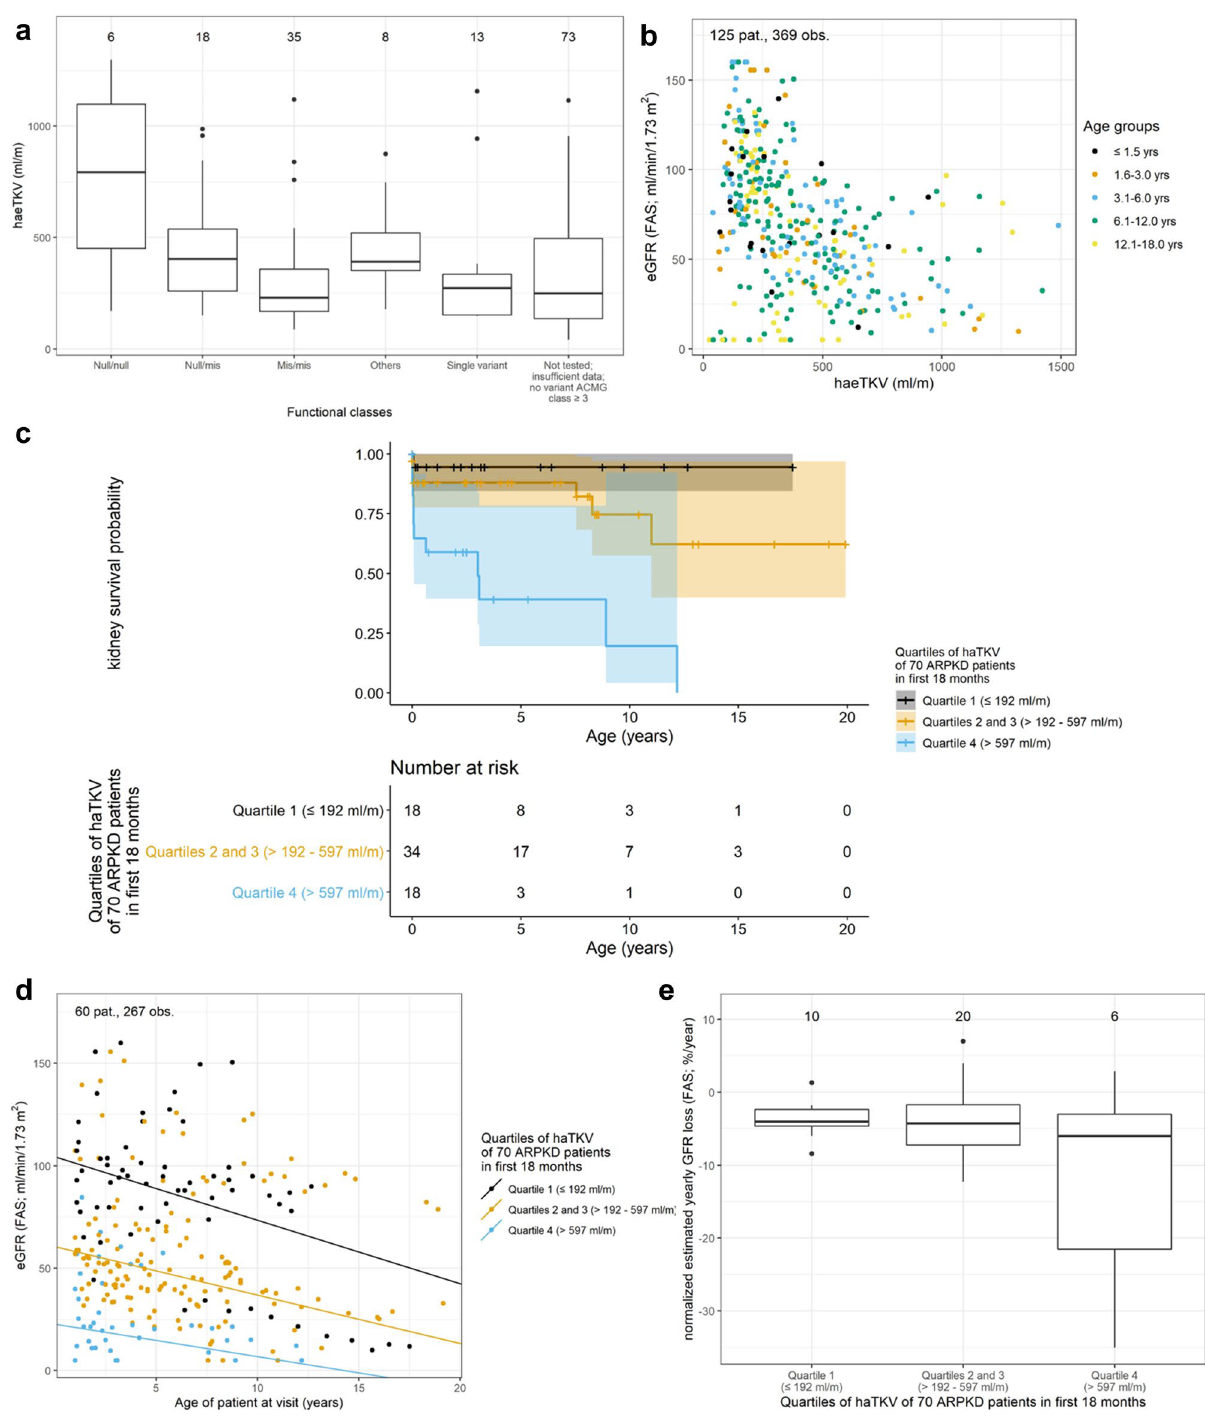
Figure 2. Correlation of haeTKV to genetics and kidney function: HaeTKV values for different groups of genotypes. The first documented haeTKV value was used for each patient ( a ). eGFR and haeTKV show a loose inverse relation in the total cohort ( b ). Kaplan–Meier of kidney survival. The highest quartile of haeTKVmax18values shows poorest kidney outcome ( c ). Scatter plot and regression lines of eGFR values of haeTKVmax18 patients stratified according to haeTKVmax18 quartiles ( d ). Normalized yearly eGFR loss of haeTKVmax18 patients stratified according to haeTKVmax18 quartiles. Only patients with at least 3 visits spanning at least one year were used to obtain valid estimations ( e